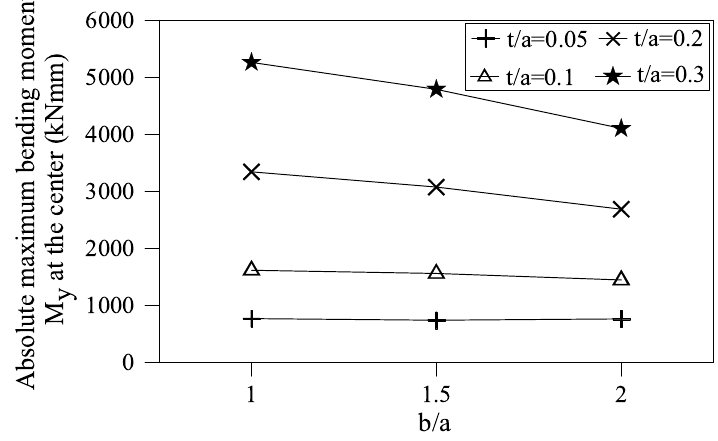
Fig. 9. Absolute maximum bending moment M y at the center of the thick simply supported plates for different aspect ratios and thickness/span ratios. aspect ratio and increases with increasing thickness/span ratio. The effects of the changes in the thickness/span ratios on this M y are generally larger than the changes in the aspect ratios. In general, degrees of decreases and increases depend on the changes in the aspect and thickness/span ratios, and the changes in the thickness/span ratio are more effective on the maximum responses considered in this study than the changes in the aspect